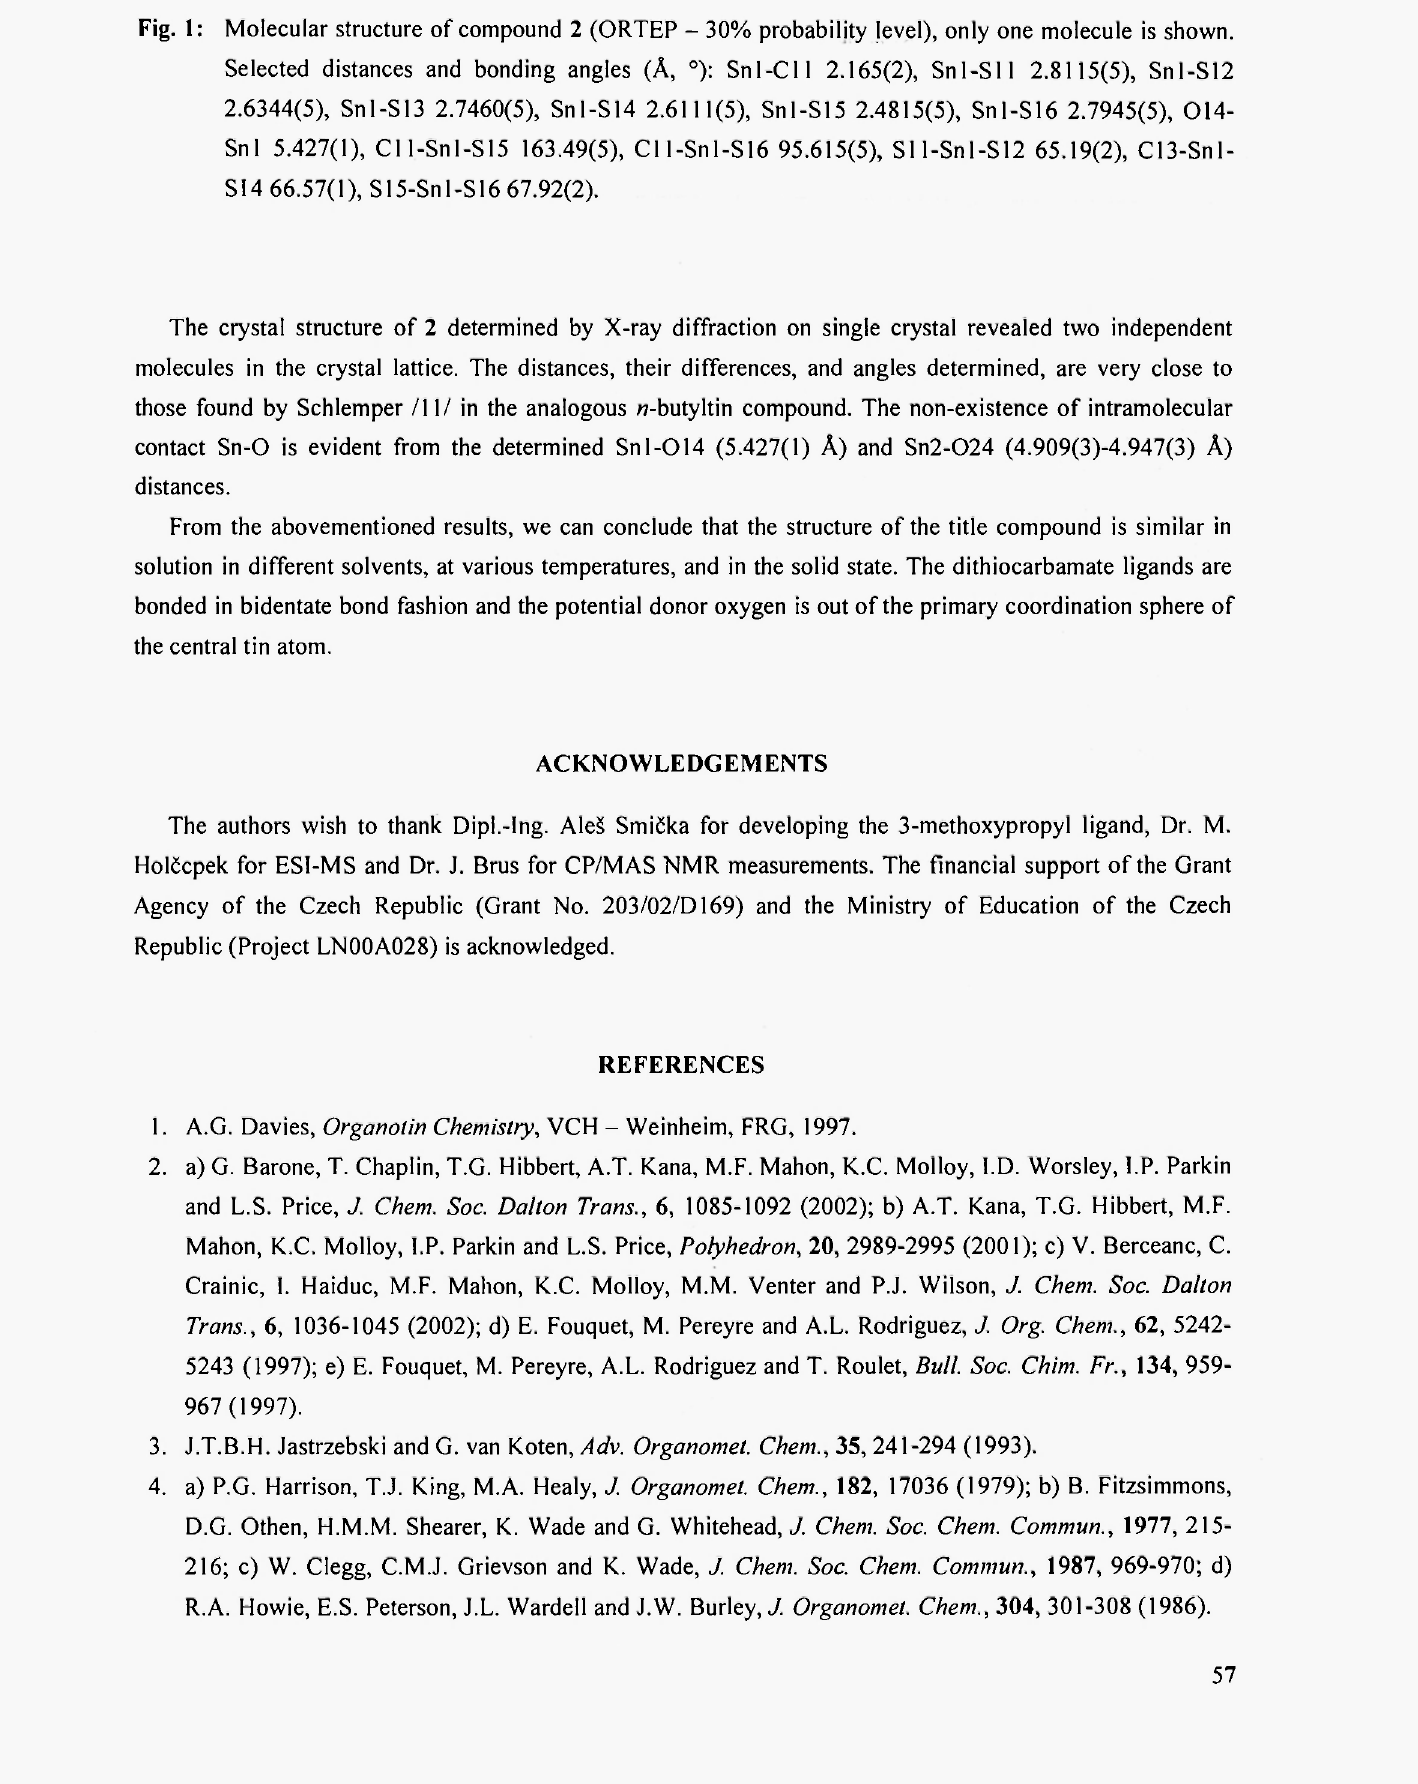
Fig. 1: Molecular structure of compound 2 (ORTEP - 30% probability (evel), only one molecule is shown. Selected distances and bonding angles